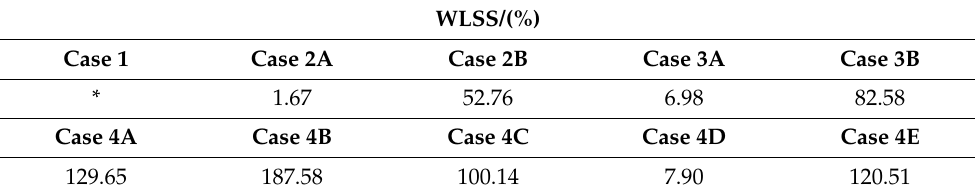
Table 5. Deviation of WLSS for for universally valid parametrization for all values in P apl